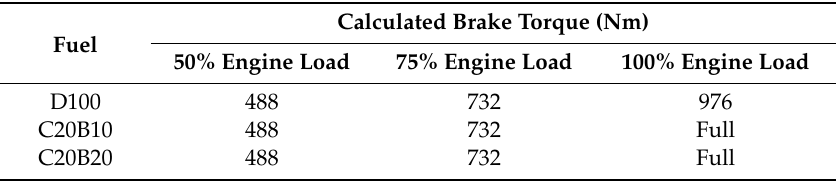
Table 7. Brake torque, calculated for individual measurement points.